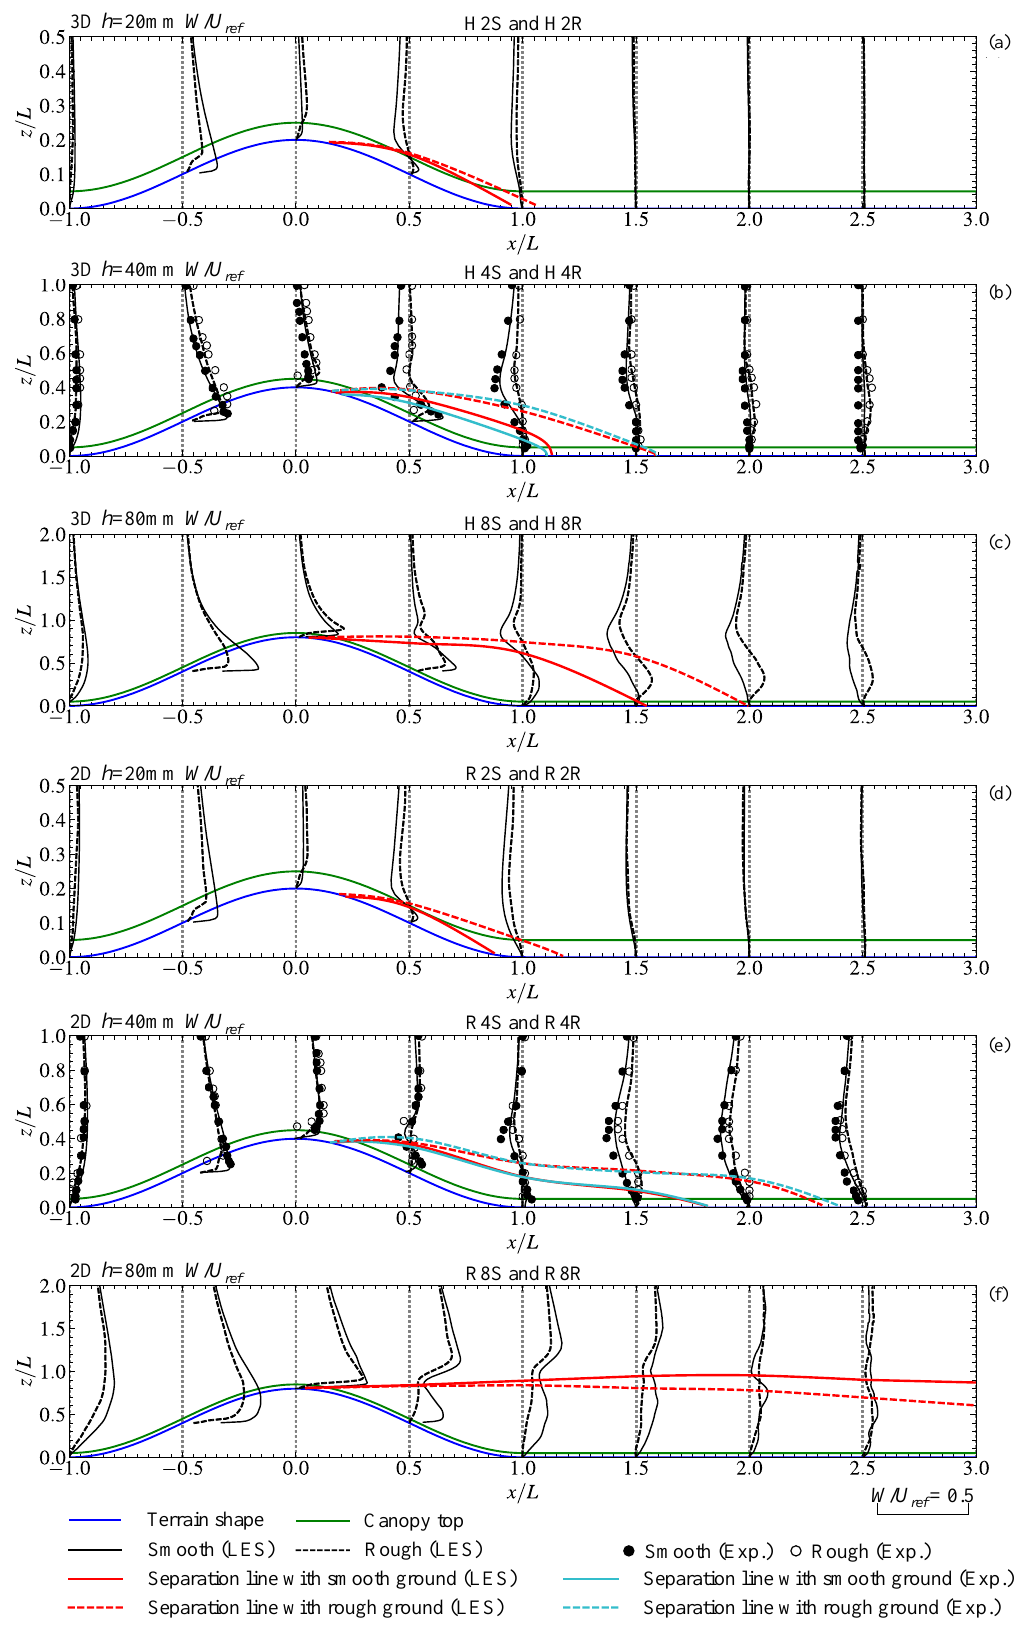
Figure 5. Vertical profiles of W , ( a ) 3D hills with h = 20 mm, ( b ) 3D hills with h = 40 mm, ( c ) 3D hills with h = 80 mm, ( d ) 2D hills with h = 20 mm, ( e ) 2D hills with h = 40 mm, and ( f ) 2D hills with h = 80 mm.